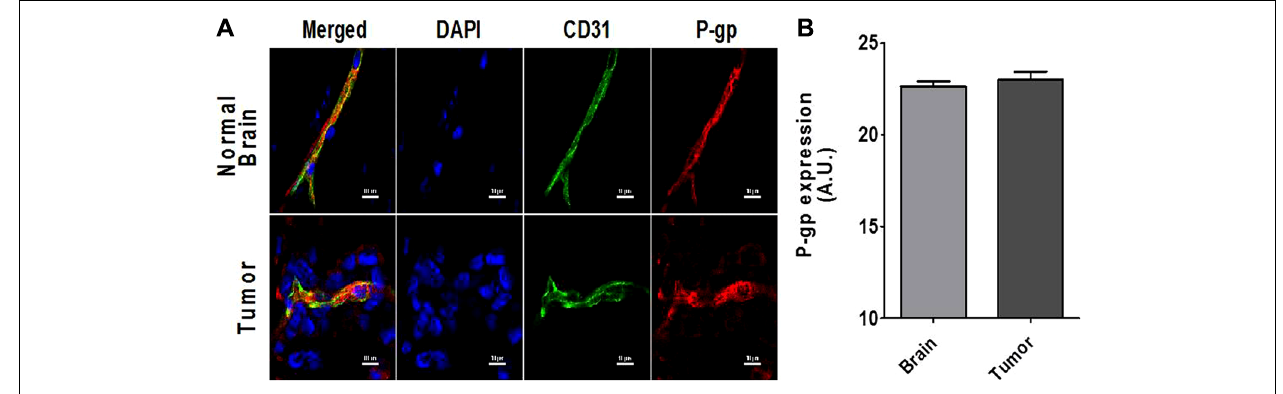
in both sections are shown in green (Alexa Fluor 488). P-gp expression is shown in red (Alexa Fluor 594). (B) The bar graph shows the relative P-gp expression per vessel as defined by CD31 stained regions. Mean + SEM; BTB; n = 756 vessels and BBB n = 1214